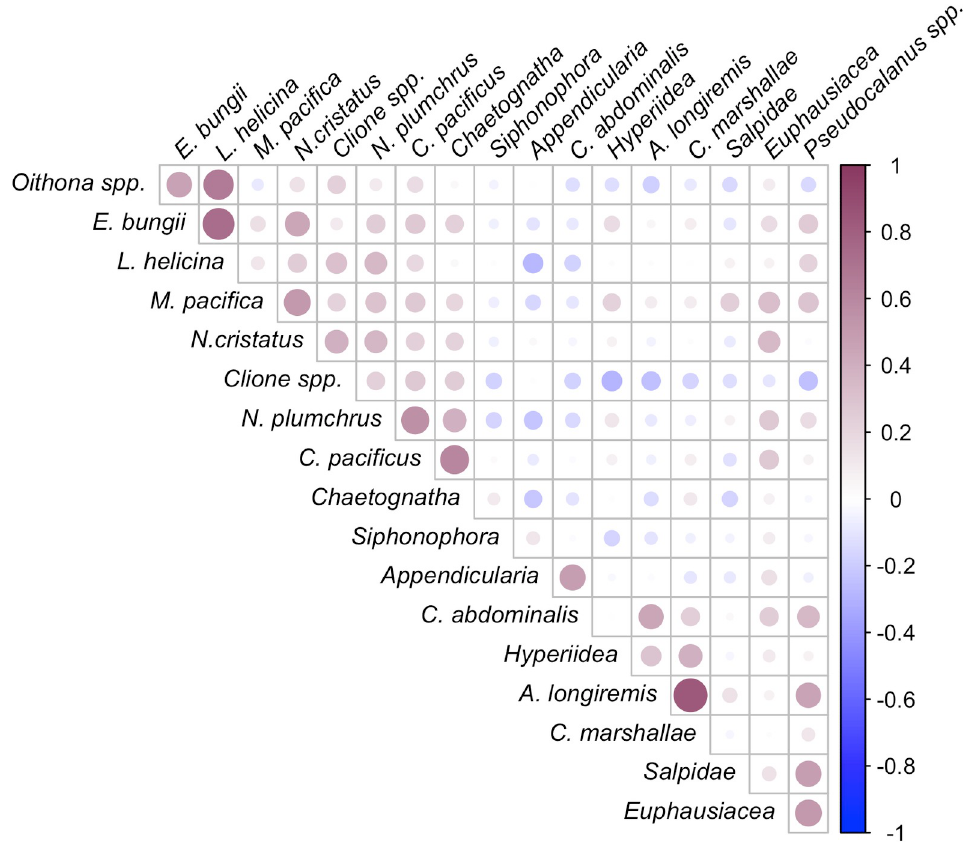
Fig 2. Pearson correlation coefficient between mean abundance of 20 zooplankton taxa used in this study. The size and color of circles are proportional to the strength of each correlation coefficient, with red representing positive correlations and blue negative correlations. ( p <